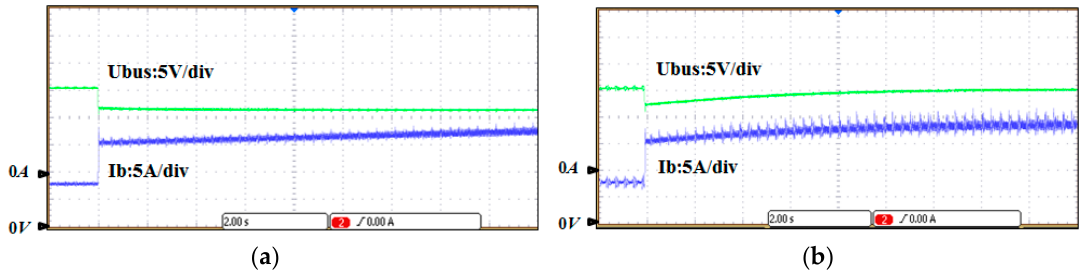
Figure 10. Experimental results of power of CPL stepping from 20W to 200W: ( a ) The #1 experimental results of DC bus voltage, load current and battery current; ( b ) The #2 experimental results of DC bus voltage, load current and battery current.